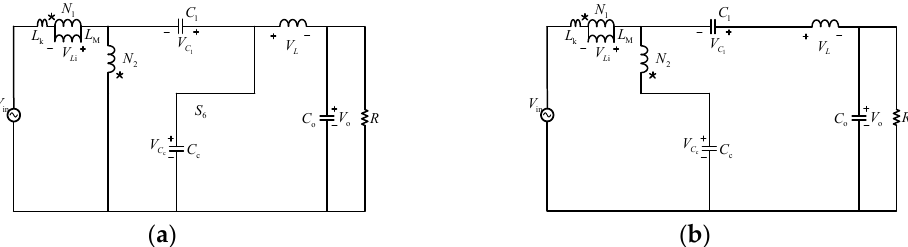
Figure 3. Two steady-states of the proposed converter: ( a ) shoot-through state; ( b ) non-shoot through state.